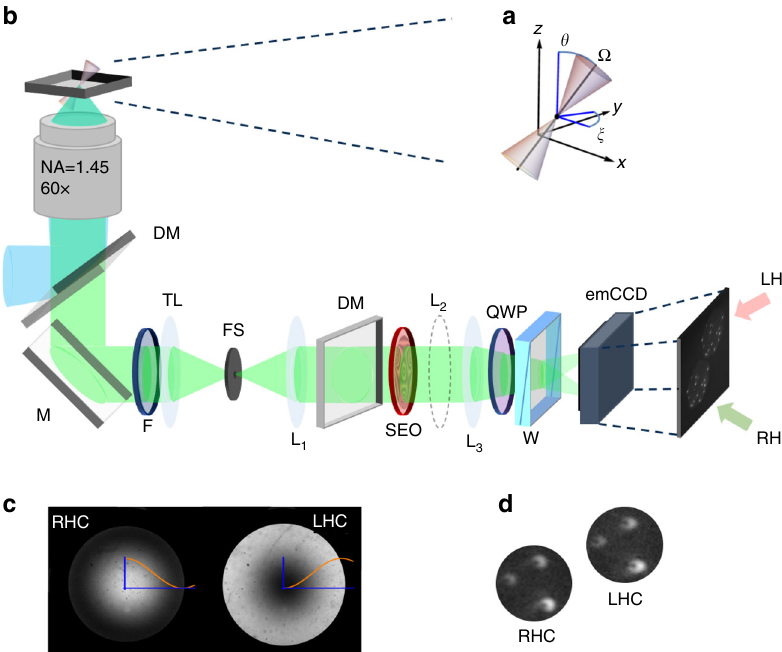
Fig. 1 CHIDO imaging principle. a Parameters de fi ning the 3D position ( x , y , z ), orientation ( ξ , θ ), and wobbling-subtended solid angle Ω . b Optical setup (see “ Methods ” ). DM dichroic mirror, M mirror, F fl uorescence fi lter, TL tube lens, FS fi eld stop. L 1 , L 2 , and L 3 lenses, QWP quarter-wave plate, W Quartz Wollaston polarizing beamsplitter, emCCD emCCD camera, RHC and LHC right-hand circular and left-hand circular polarized images. c Back-focal plane imaging of the SEO illuminated by a circular polarization (the sample is a homogeneous fl uorescent sample, see “ Methods ” ). d Direct image of isolated emitters ( fl uorescence beads, see Section “ Methods ” ) in the same polarized emission